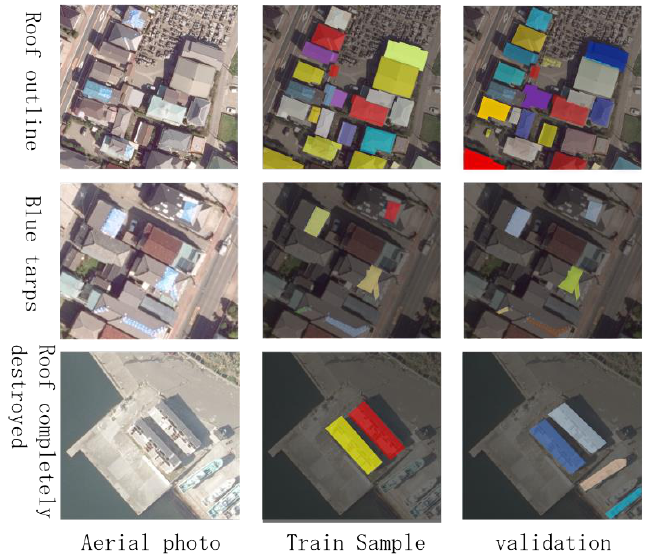
Figure 10. The validation in the training.